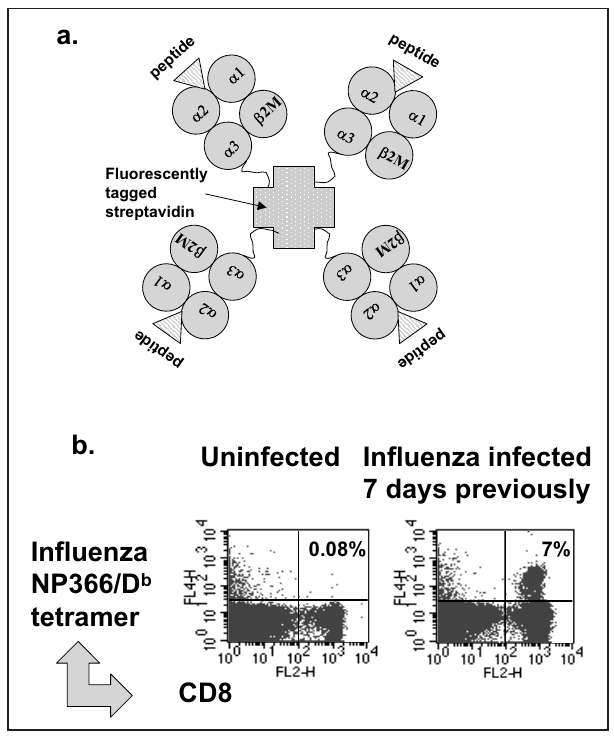
Figure 6) Major histocompatibility complex (MHC)/peptide tetramers can be used to monitor antigen-specific T cells. a) Schematic